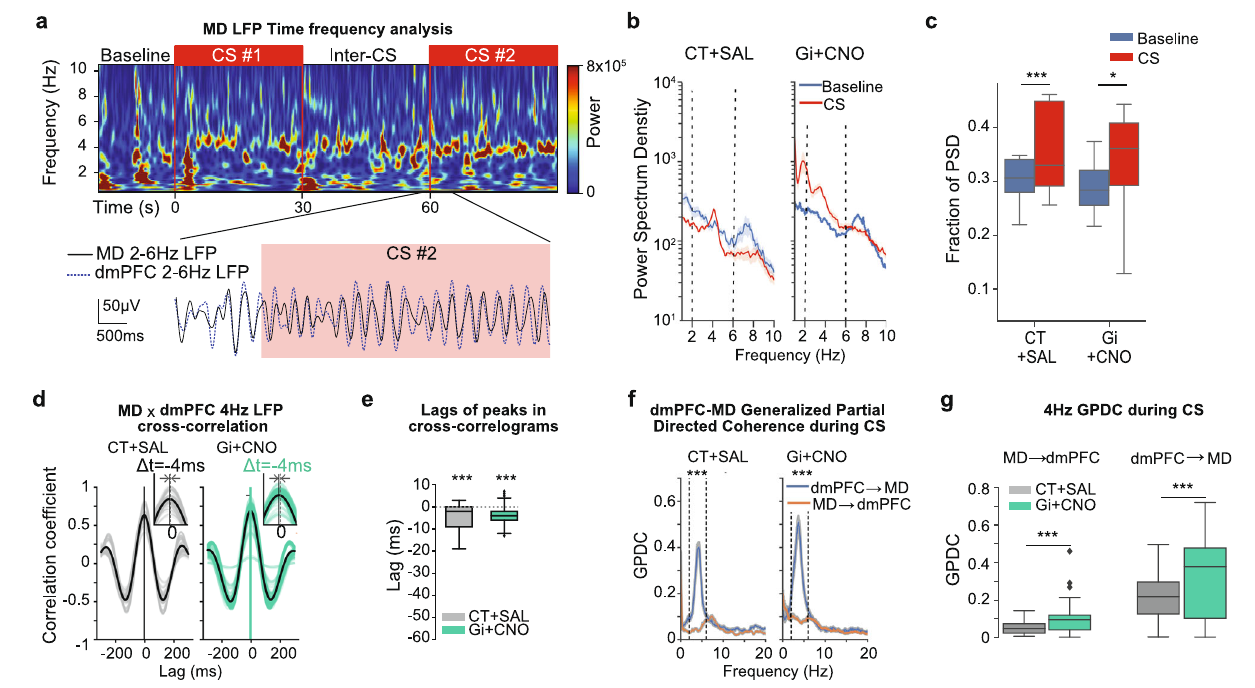
Fig. 8 | dmPFC-MD 4Hz coherence is increased by chemogenetic inhibition of FN-MD. a Representative spectrogram of MD LFP during EXT1 (top), displaying a 4Hz component induced by the CS. 2 – 6Hz fi ltered LFP traces from dmPFC (blue), showingtheapparitionof4HzoscillationsaftertheonsetoftheCS(redrectangle). b A 4Hz component (2 – 6Hz) is visible in the Power Spectrum Density (PSD) MD LFP during EXT1 for CT+SAL (left) and Gi+CNO (right), average ± SEM, dashed lines represent the 4Hz range (2 – 6Hz). c The fraction of the PSD representing 2 – 6Hz oscillations is increased during Extinction compared to Baseline. Wilcoxon test, *** p <0.001 (CT+SAL=28 recording sites from 4 mice, Gi+CNO=30 recordingsitesfrom5mice). d Cross-correlationof2 – 6Hz fi lteredLFPinMDandin dmPFC display maxima at negative lags. Colored lines represent pairwise cross- correlations. Black lines represent averages. e Lags of maximum peaks in cross-